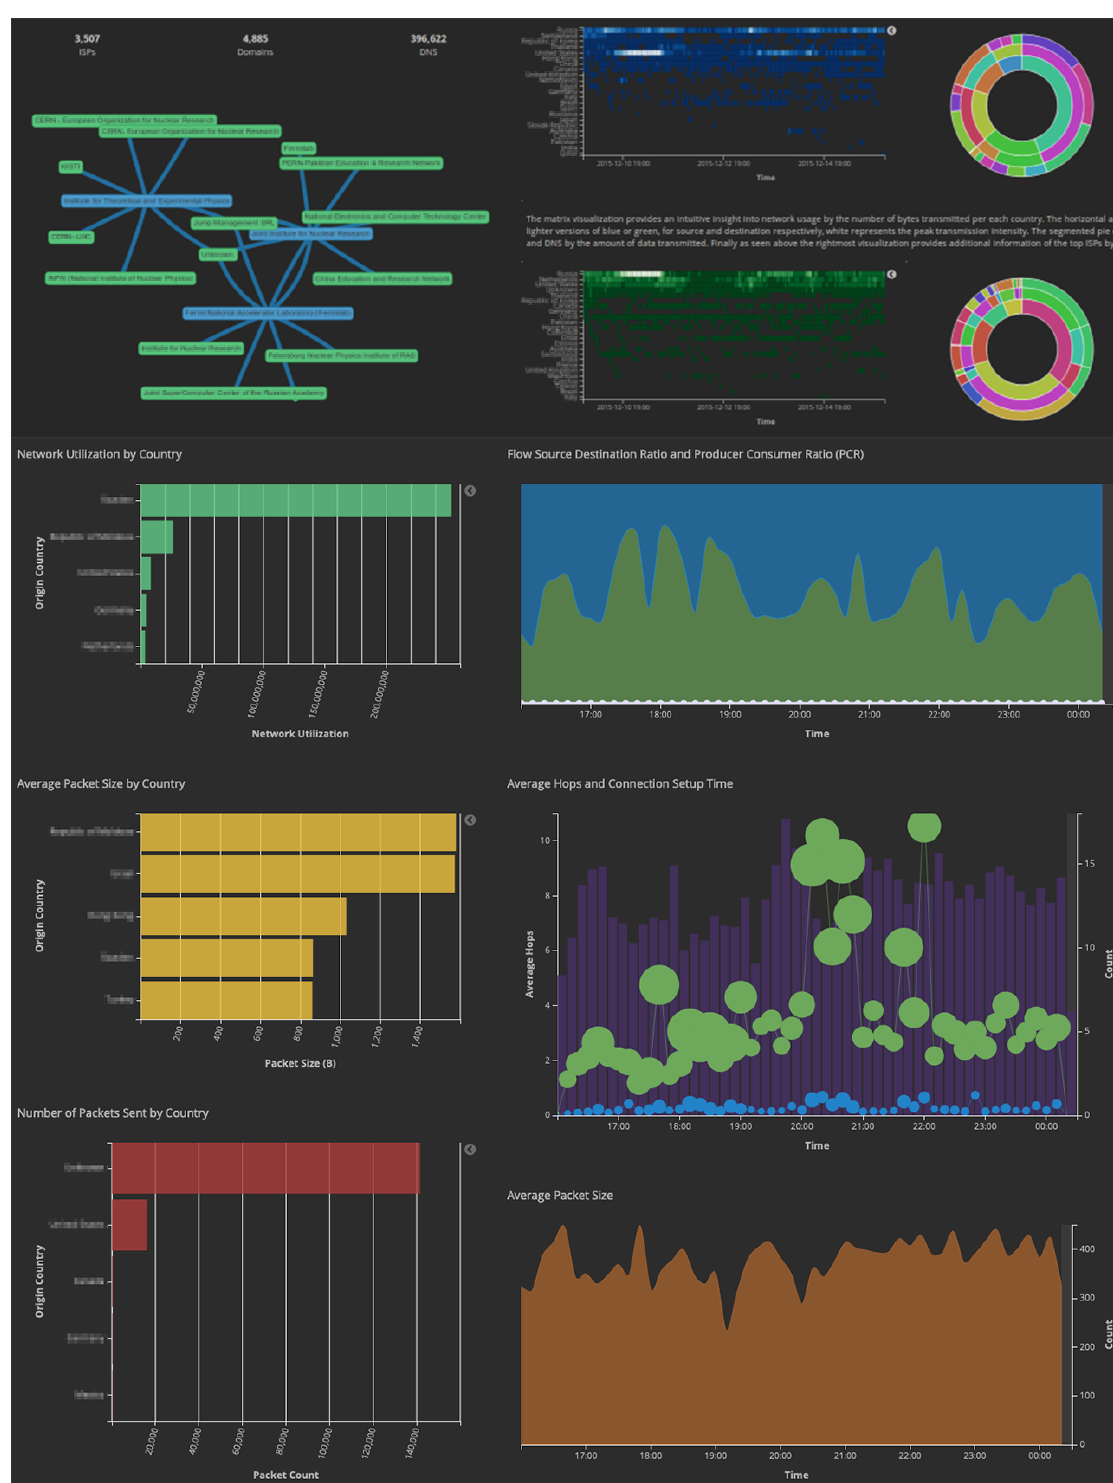
Figure 6. Network performance